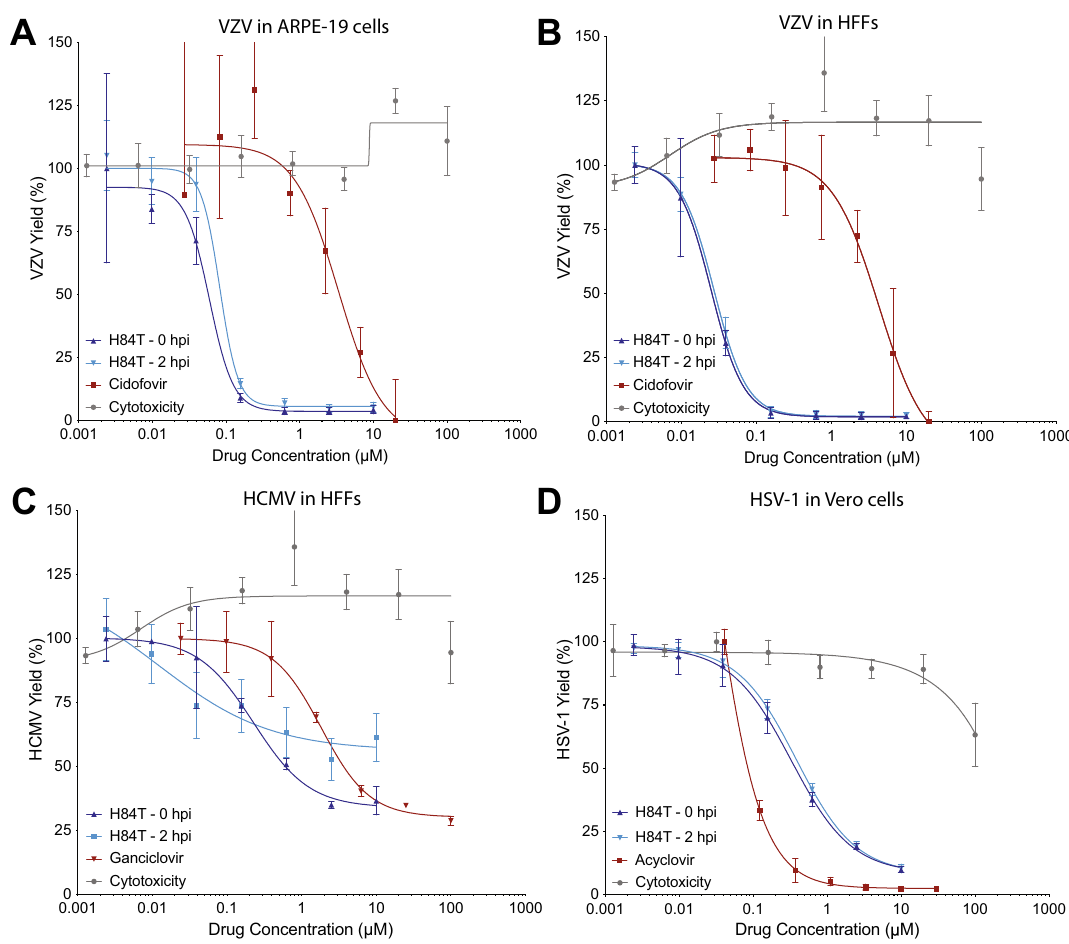
Figure 1. H84T BanLec potency against VZV, HCMV, and HSV-1 in cultured cells. Cell-free viruses were added to cell monolayers at 37 °C, and H84T BanLec or positive control antiviral compounds were added at 0 h post-inoculation (HPI) or 2 HPI. The antiviral compounds remained in the culture medium until virus yield was measured by bioluminescence imaging. ARPE-19 cells or HFF cells were infected with VZV for 3 days ( A , B ), HFF cells were infected with HCMV for 7 days ( C ), and Vero cells were infected with HSV-1 for 2 days ( D ). Virus yield was calculated from the average Total Flux of untreated wells divided by the average Total Flux of the treated wells. H84T BanLec cytotoxicity was measured using a neutral red dye uptake assay in Vero cells treated for 48 h ( D ) and HFFs or ARPE-19 cells treated for 72 h ( A – C ). Each point represents the mean ± SD. N = 3–6 biological